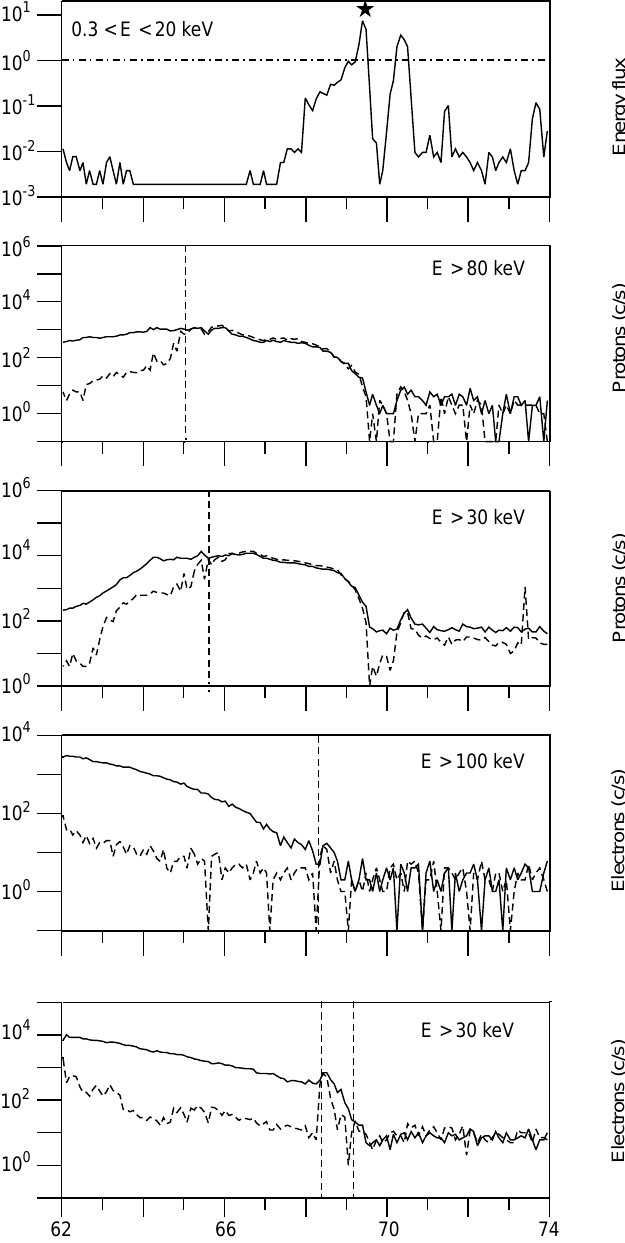
2200–2204 UT 01 August 1979. f (Event 6) 2255–2301 UT 15 August 1979. g (Event 7) 2332–2338 UT 21 August 1979. Horizontal hard solid bars mark the latitudinal region occupied by the di(cid:128)use auroras. h (Event 8) 0003–0012 UT 19 August 1979. No discrete auroral forms were detected during this crossing. i (Event 9) 0147–0154 UT 19 August 1979. Note that in this case it is impossible to determine the exact location of most equatorward auroras because they were very far from zenith of the all-sky camera. j (Event 10) 1721–1726 UT